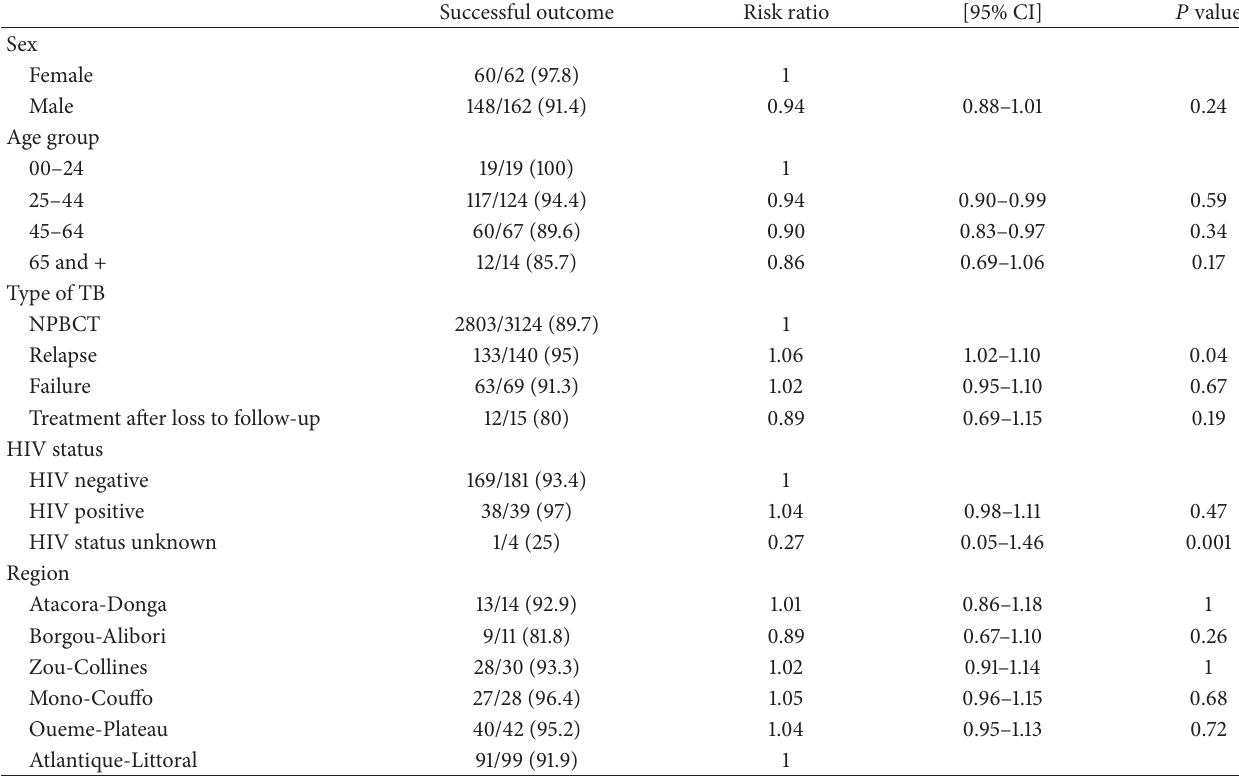
Table 6: Factors associated with a successful treatment among retreatment tuberculosis patients, 2013,